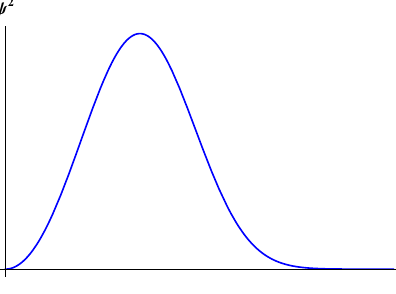
Figure 1. Profile of ψ 2 ( a , φ ) , for φ